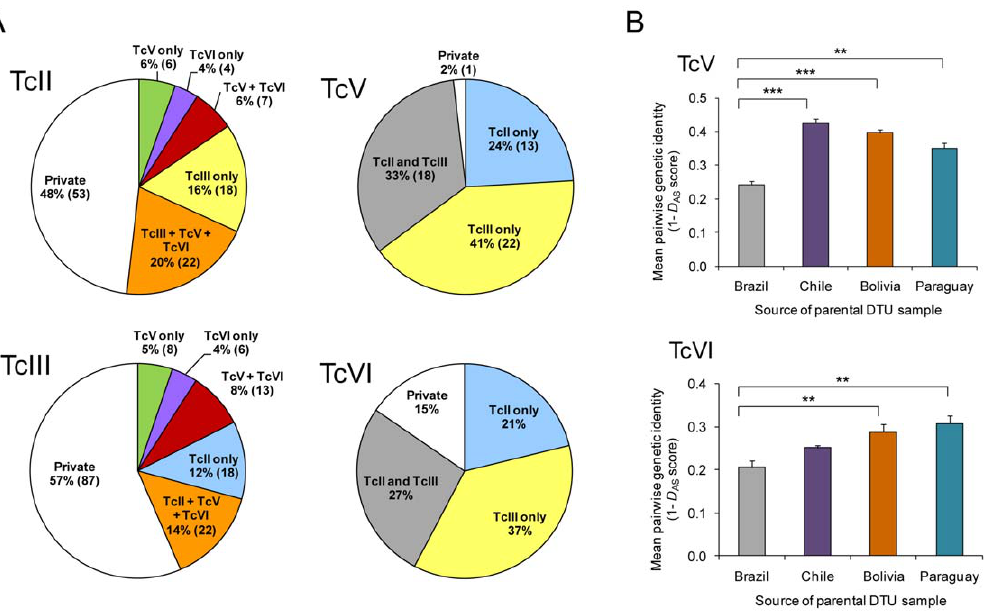
Figure 4. Patterns of microsatellite allelic inheritance in hybrid lineages TcV and TcVI. Based on analysis of 19 locus and 28 locus data sets combined. A) For each parental (TcII, TcIII) and hybrid (TcV, TcVI) group the charts show the proportion of microsatellite alleles that were also found in each of the other three groups and the proportion of private alleles – those not found in any of the other three groups. B) Mean pairwise genetic identities (1- D AS ) between hybrid group (TcV and TcVI) MLGs and parental group (TcII and TcIII) MLGs from different geographical regions; DTU, discrete typing unit; error bars are S.E.M; brackets represent statistically significant 2-tailed t-tests with asterisks indicating: ** p , 0.01, *** p , 0.001.